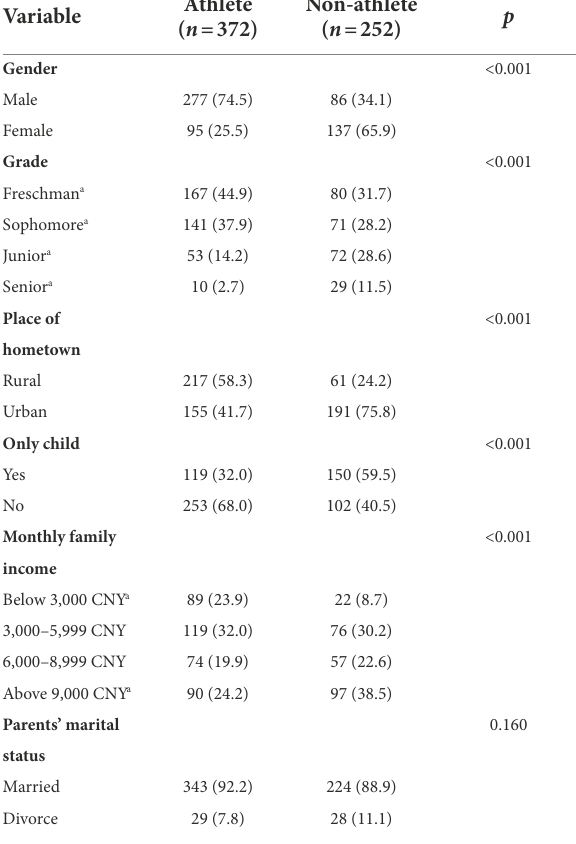
TABLE 1 Characteristics of athlete and non-athlete students, n